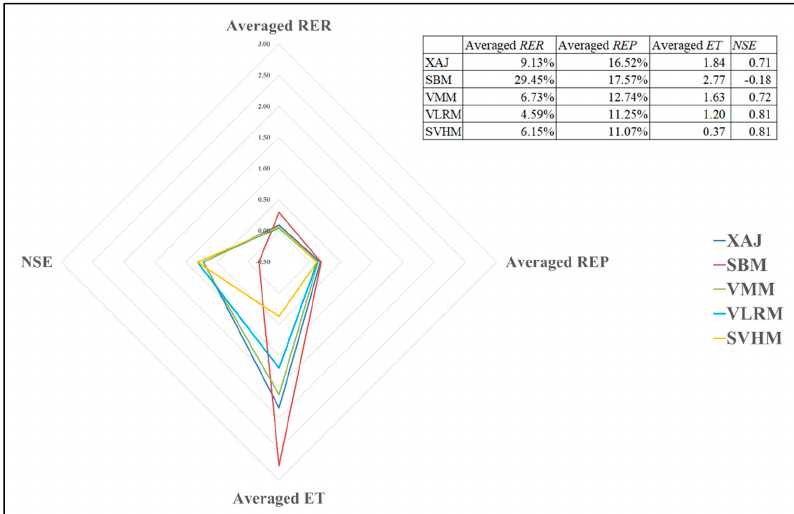
Figure 11. Comparisons of performance measures for different models in simulating all flood events in Xiuwu Basin (Note: REP denotes the relative error of flood peak, RER denotes the relative error of total runoff depth, ET denotes the error of peak appearance time and NSE denotes the Nash–Sutcliffe efficiency coefficient. REP and RER range from 0 to 1, NSE ranges from − 0.5 to 1 and ET ranges from 0 to 3).